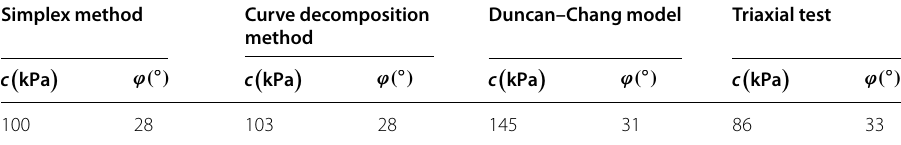
Table 4 Couple of values ( c , ϕ ) of the site “Nogent-sur-Seine” for triaxial test and different methods Simplex method Curve decomposition